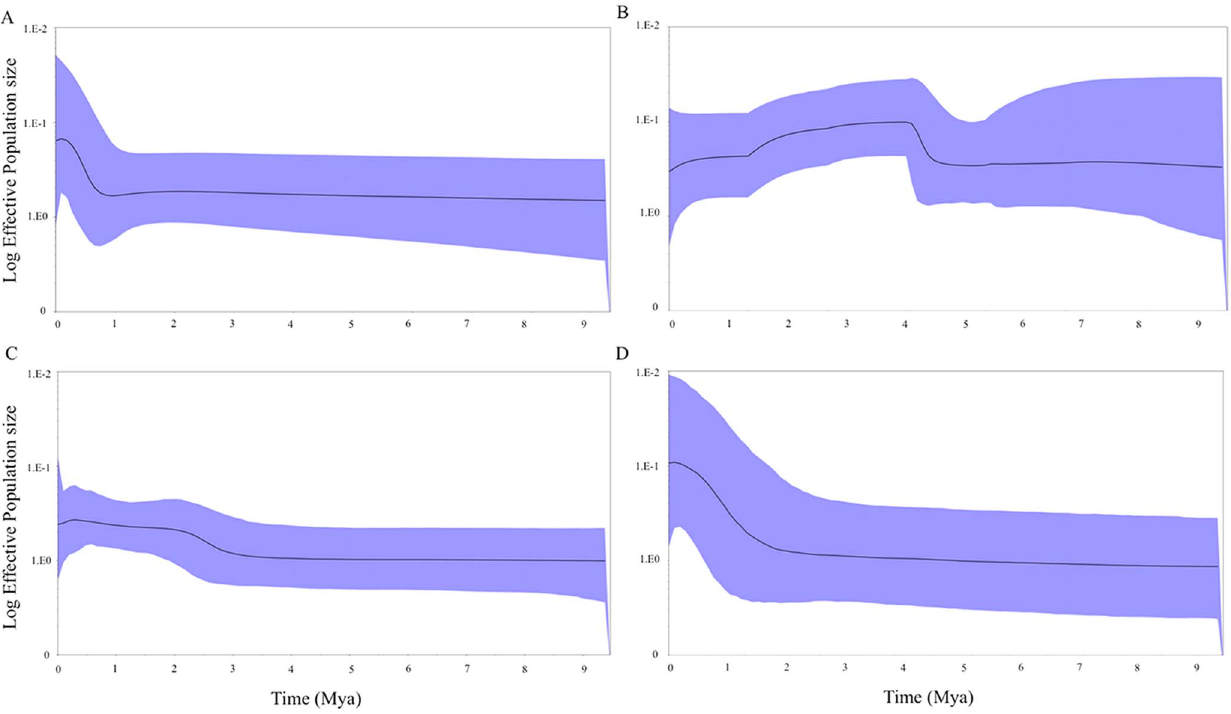
Figure 6. Bayesian skyline plots showing T.dimidiata population size changes over time. The relative population size measured as a product-effective population size (y-axis) is shown over time in millions of years (x-axis) in simulated coalescent-based genealogies using A) ND4 Colombian haplotypes, B) combined ND4 and CO1 Colombian haplotypes, C) ND4, and D) partial ITS-2 haplotypes including Central American and Mexican conspecific sequences (Table S1). The thick black line is the median estimate and the solid (blue) interval shows the 95% highest posterior density limits.